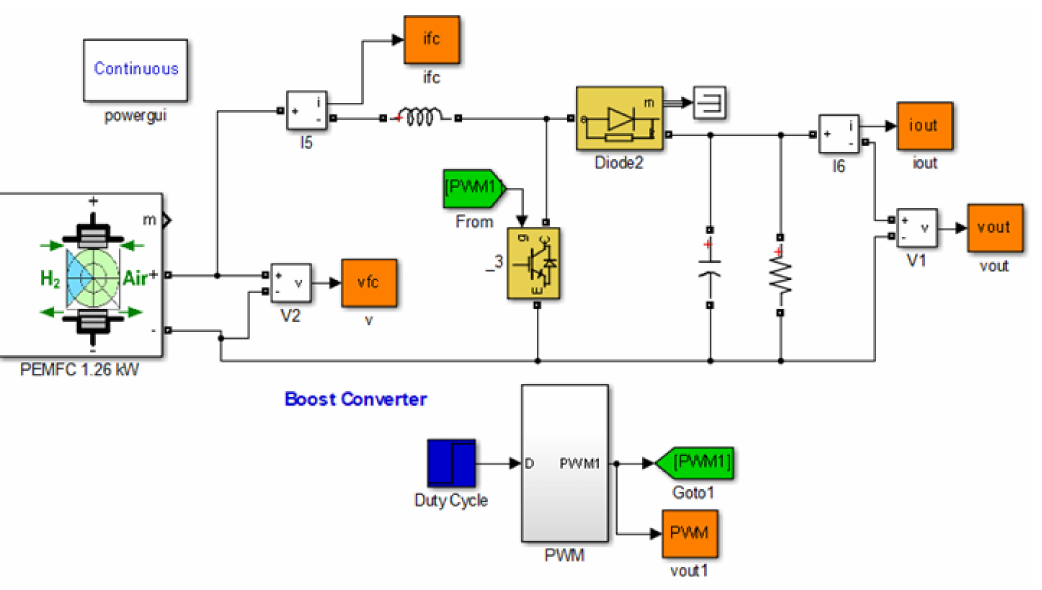
Figure 1. Fuel Cell-Boost Converter